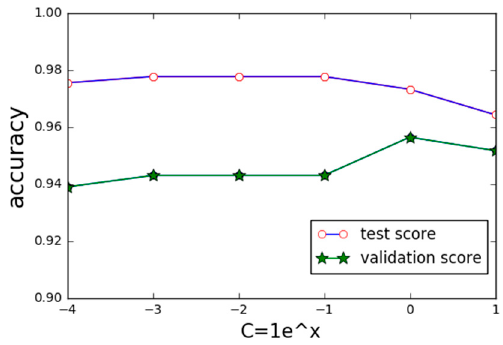
Figure 9. Selection of penalty factor C in the two categories.